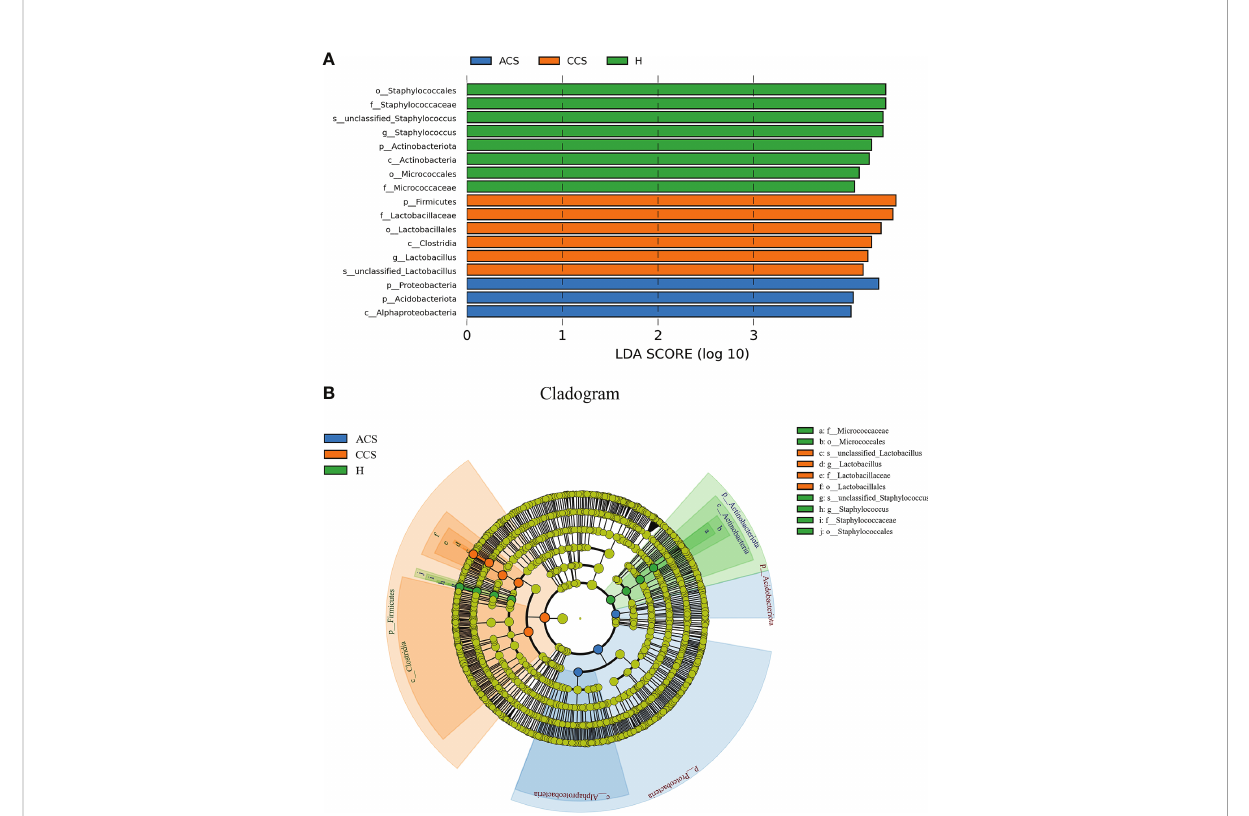
FIGURE 4 (A) LEfSe identi fi ed the most differentially abundant clades at all taxonomic levels among acute coronary syndrome, chronic coronary syndrome, and healthy groups using the LDA score of 3. (B) Cladogram of differentially abundant bacterial taxa wherein each layer represents a